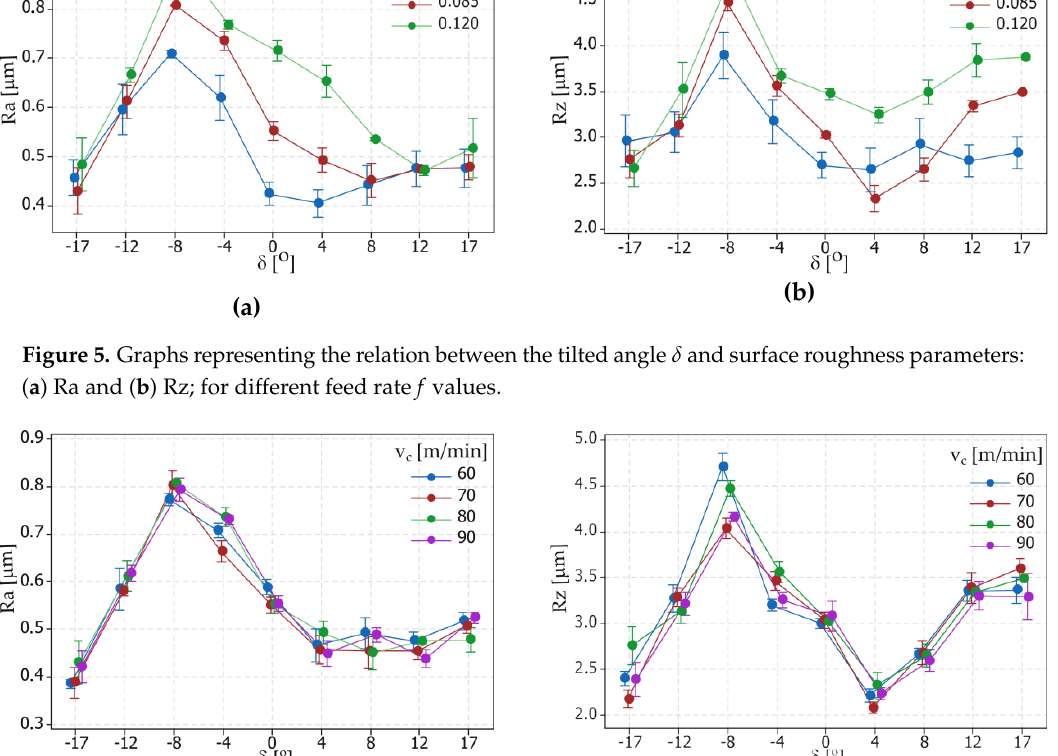
Table 4. Analysis of ANOVA variance for surface roughness parameter Ra.